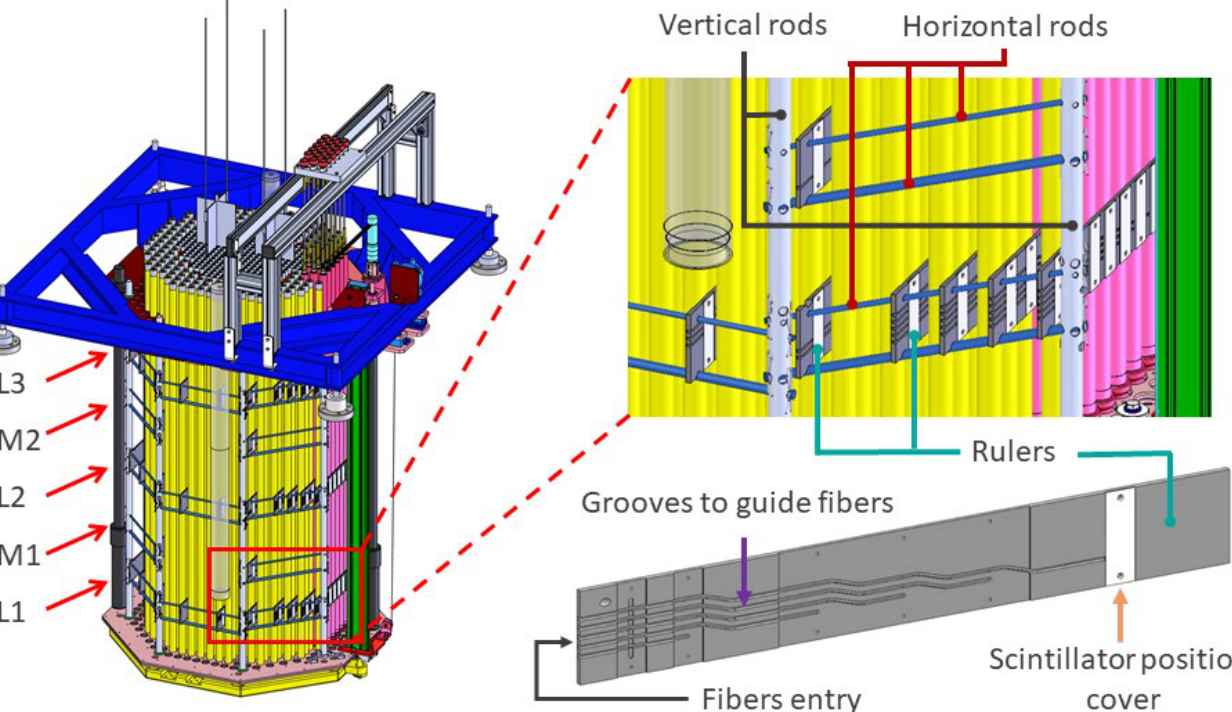
Fig. 4. SolidWorks model of the 3D full-core mapping system installed in the CROCUS reactor core and zoom on the main components of the system. Fig. 4.